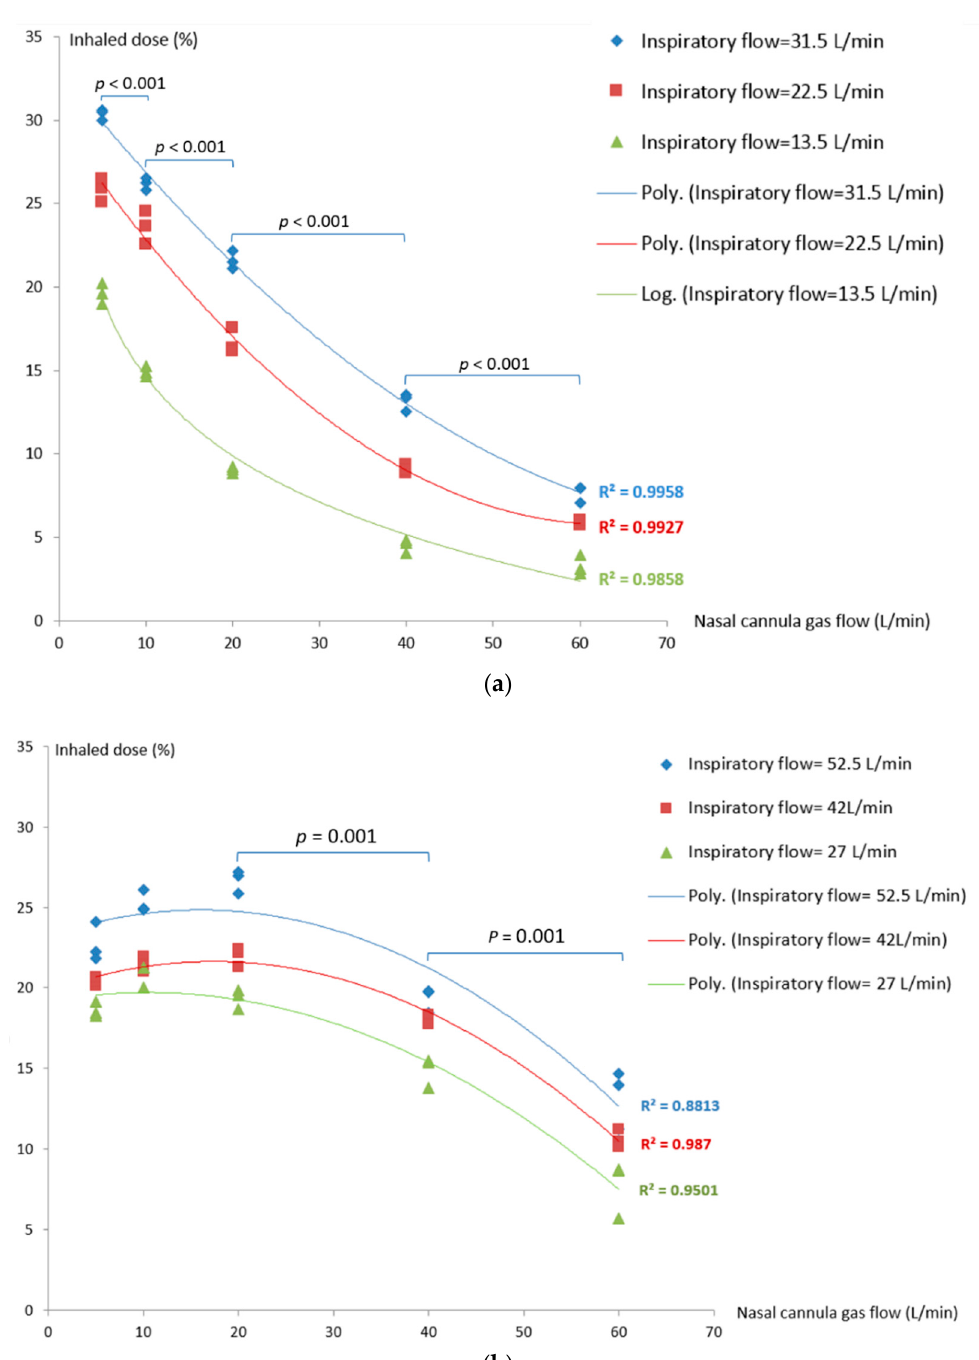
Figure 2. Inhaled dose during different breathing patterns: (a) Quiet breathing; (b) distressed